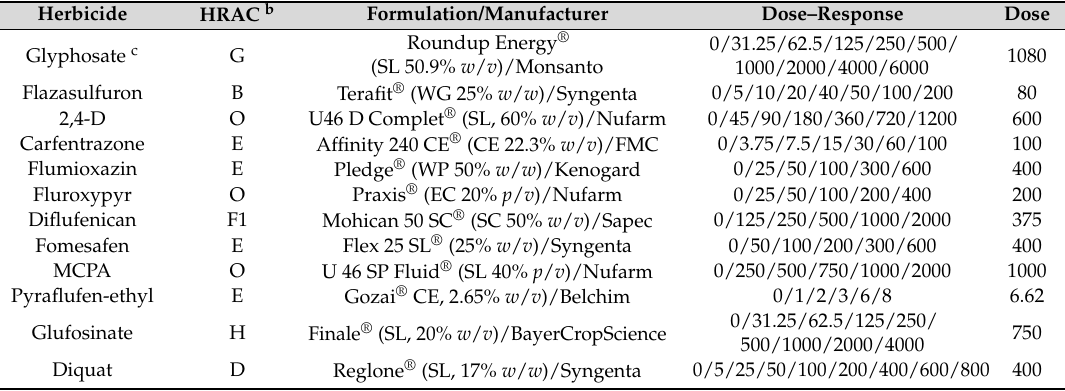
Table 2. Herbicides, formulation (type and concentration) a /manufacturer, HRAC group, doses used in the curve dose–response in g ai ha − 1 (Dose–response), and recommended field doses in g ai ha − 1 (Dose) applied on C. canadensis populations from Spain (GR and GS) and Hungary (H1–H8) at the rosette stage (BBCH